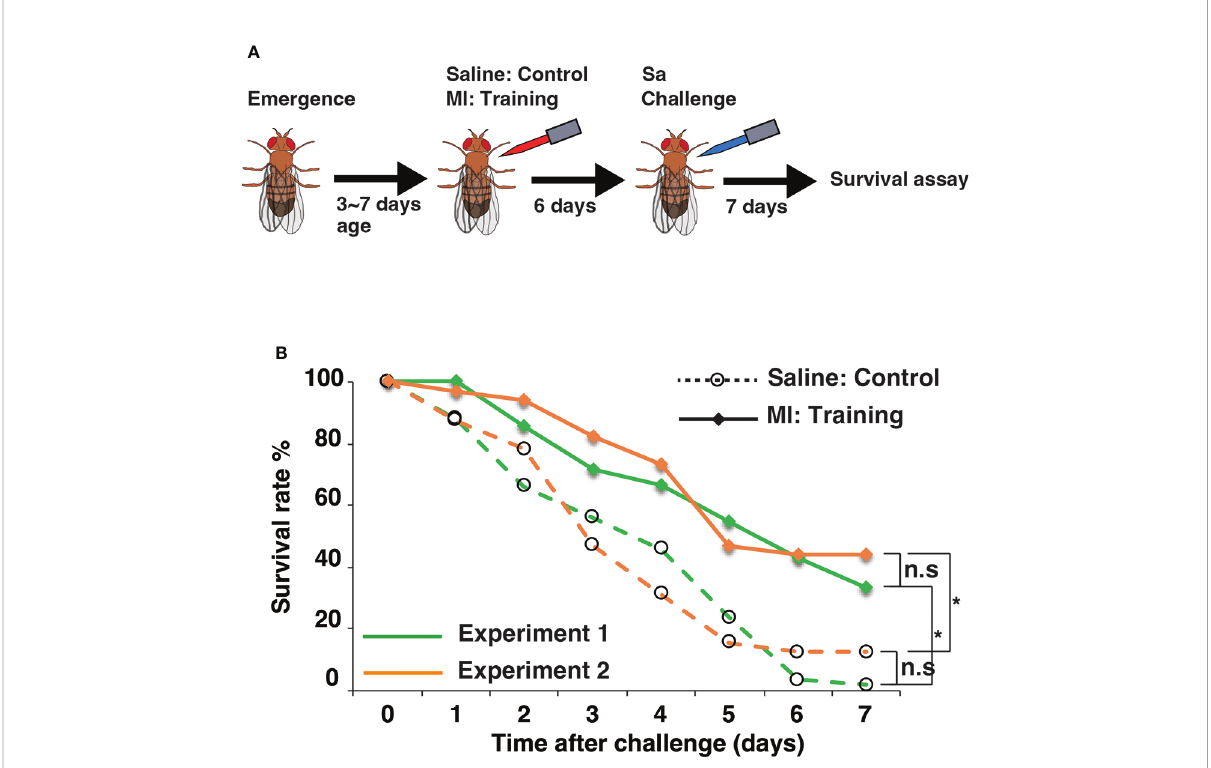
FIGURE 1 Experimental system of innate immune memory in Drosophila . (A) Schematic drawing of the systemic infection experiment. Low pathogenic Micrococcus luteus (Ml) was injected into the body cavity of fl ies for training, and lethally pathogenic Staphylococcus aureus (Sa) was injected 6 days later for the challenge. Fly survival was monitored for 7 days. (B) Survival rates after Sa challenge under control and training conditions. Average survival rates for two experiments are shown in green and orange lines. *, p-value < 0.05; n.s, not signi fi cant, determined using the log-rank test and Tukey ’ s HSD post-hoc test. Data of replicates in same experiment are shown in Supplementary Figure